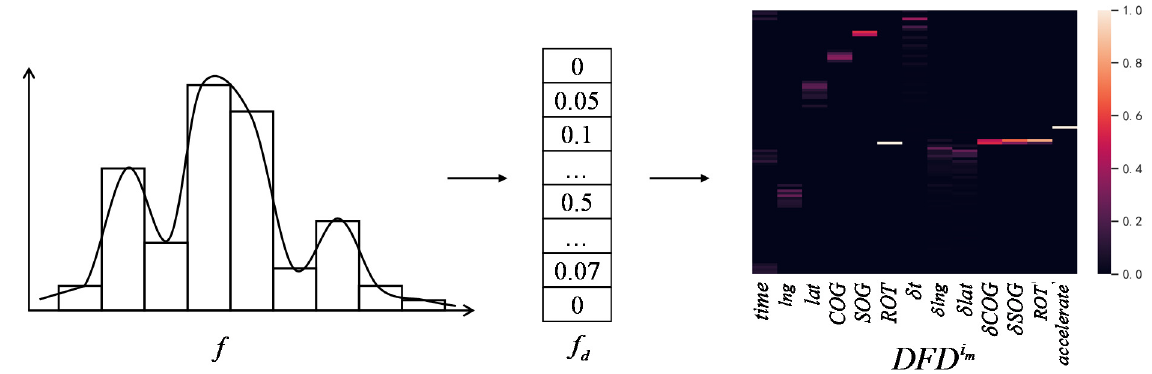
Figure 8. Process of extracting dynamic features distribution.